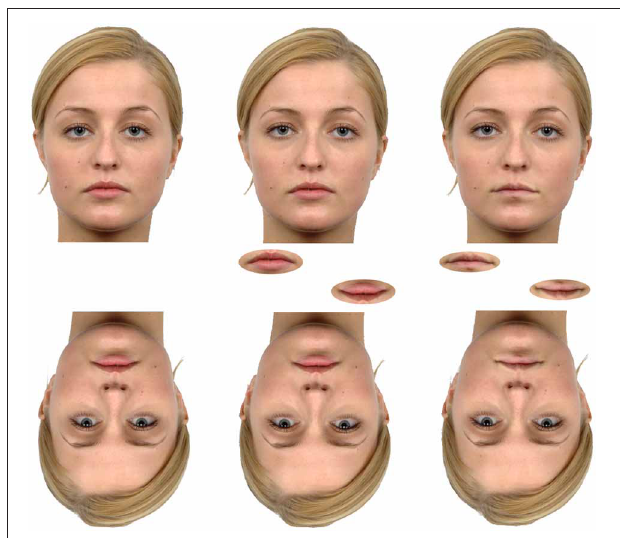
FIGURE 2 | Featural and configurational changes to upright and inverted faces. The central face is the original (Langner et al., 2010) while the face to the left has eyes that have been moved closer to the bridge of the nose. The face to the right has had the mouth replaced with that of another person. Between the upright and inverted faces are the target features isolated from the face. Configurational/holistic processing suggests the changes should be more apparent in the upright, whole faces compared to the inverted faces or when the features are